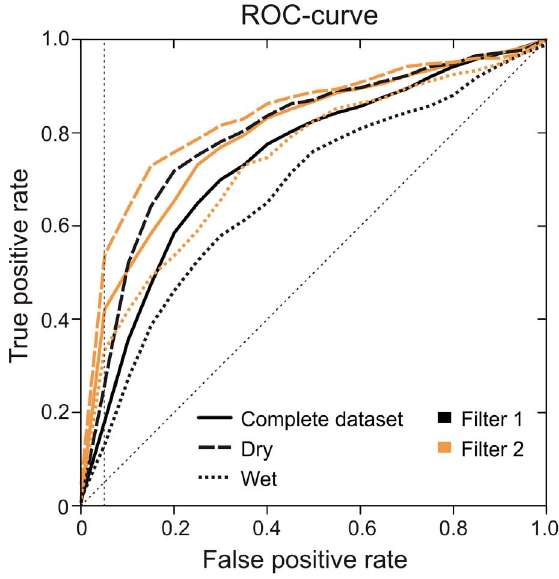
Figure 1. Possible gain (true positive rate, TP-rate) given an accepted loss (false positive rate, FP-rate). The FP-rate represents the proportion of target recordings (beavers) classified as non-target recordings. The TP-rate is the proportion of non-target recordings correctly classified as non-target. This is the proportion of non-target recordings that will be discarded correctly given a certain FP-rate. The best performing filter maximizes the TP-rate while minimizing the FP- rate. Filter 2 performs better in all environmental circumstances. The dashed diagonal represents the outcome of a random model which cannot discriminate between target and non-target recordings. The dashed vertical line represents a 5% threshold (FP-rate). Dry , 10% water area in footage (5 locations, n=933 recordings), Wet . 10% water area (7 locations, n=1058 recordings), Complete dataset is the combined Dry and Wet dataset (12 locations, n=1991